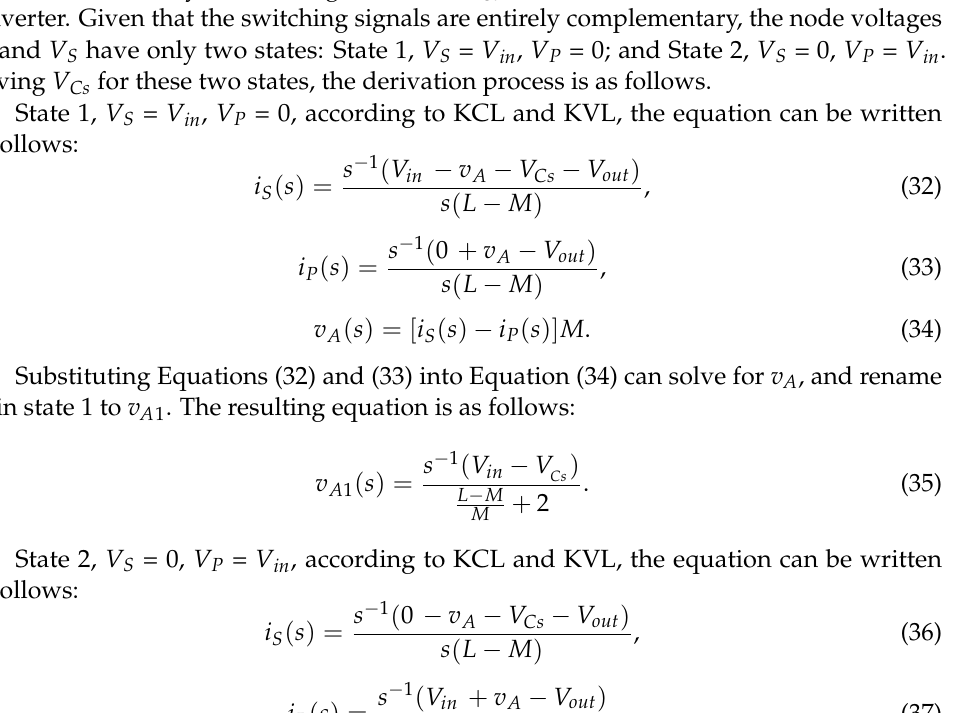
Figure 14. Stacked buck converter with coupled inductor equivalent T model.